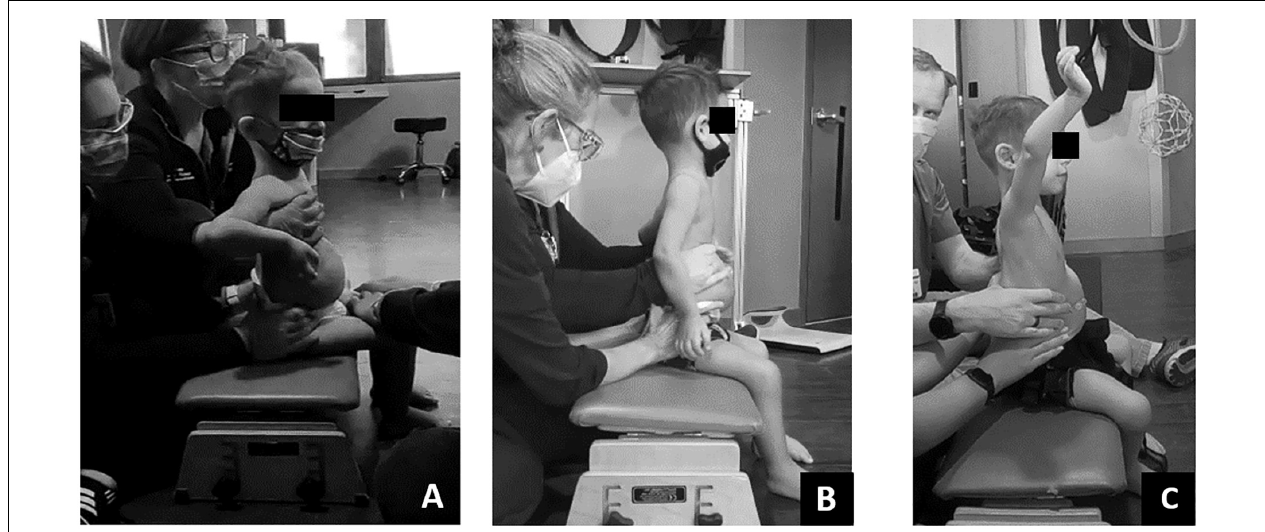
FIGURE 3 | Changes in Segmental Assessment of Trunk Control (SATCo) across time. (A) Initial evaluation with neutral pelvis and support at axillae. (B) At 20 sessions of ABRT neutral pelvis and support at inferior scapulae and trunk controlled above. (C) Upon discharge evaluation with neutral pelvis external support at low ribs and trunk control